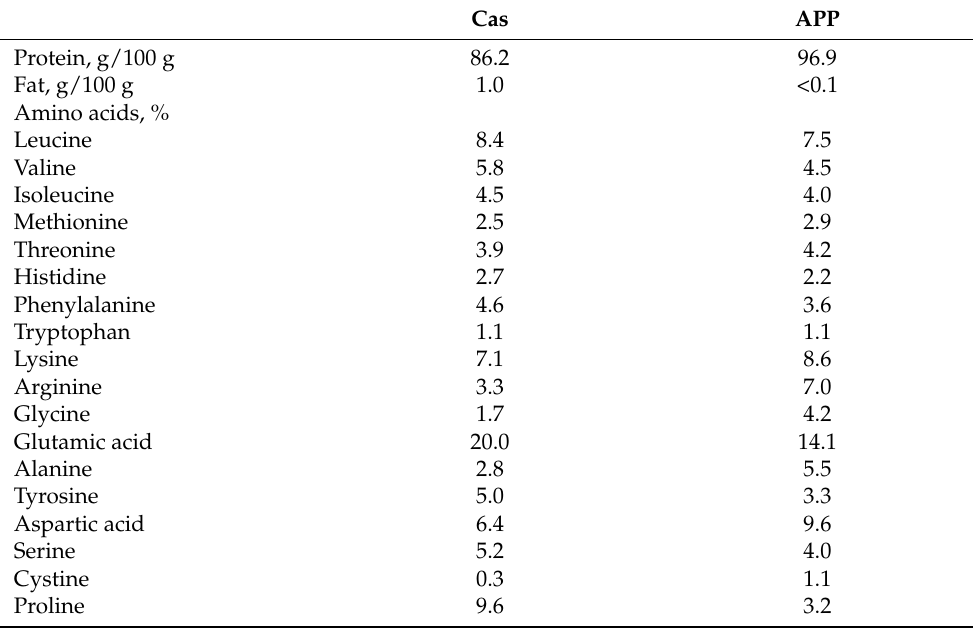
Table 1. The nutritional profile and amino acid composition of protein sources.